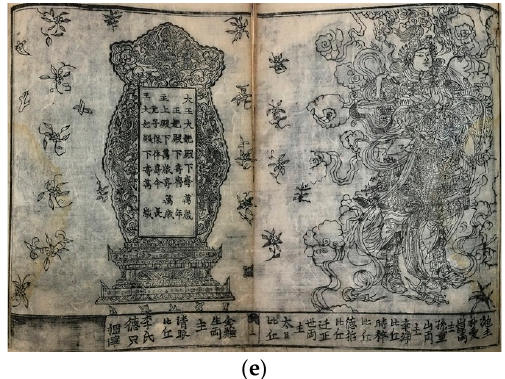
Figure 17 . Lotus Sutra (Gapsa edition), published by Gapsa Temple, Joseon (1670), 16.7 × 25.4 cm, (( a ) first woodblock print; ( b ) second woodblock print; ( c ) third woodblock print; ( d ) fourth woodblock print; ( e ) fifth woodblock print) , Jangseogak Archives. Photo by the author. The frontispiece illustration for this text was made from five woodblocks and is a diverse mixture of the iconography of the Gongsanbonsa edition and prints from various other sutras. The first woodblock contains the scene of Skanda and the appearance of a pagoda from the Gongsanbonsa edition; the second and third woodblocks the Assembly of the Buddhas of the Three Ages (K. Samsebulhoedo 三世佛會圖 ; Sakyamuni, Amitabha and